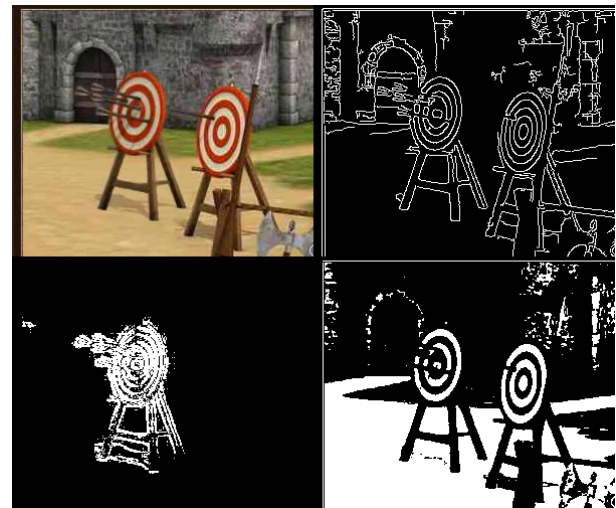
Figure 1 . The figure shows the saliency analysis of one sin- gle frame from an animated advert: original advert (top-left), edge pixels (top-right), motion pixels (bottom-left), and lu- minance pixels (bottom-right). The number of white pixels in each sub-image constitutes the respective values for the saliency measures on this